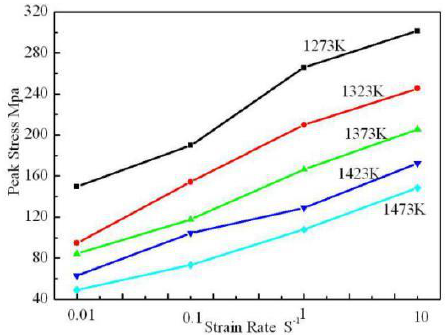
Figure 5. Flow stress peaks at different strain rates.